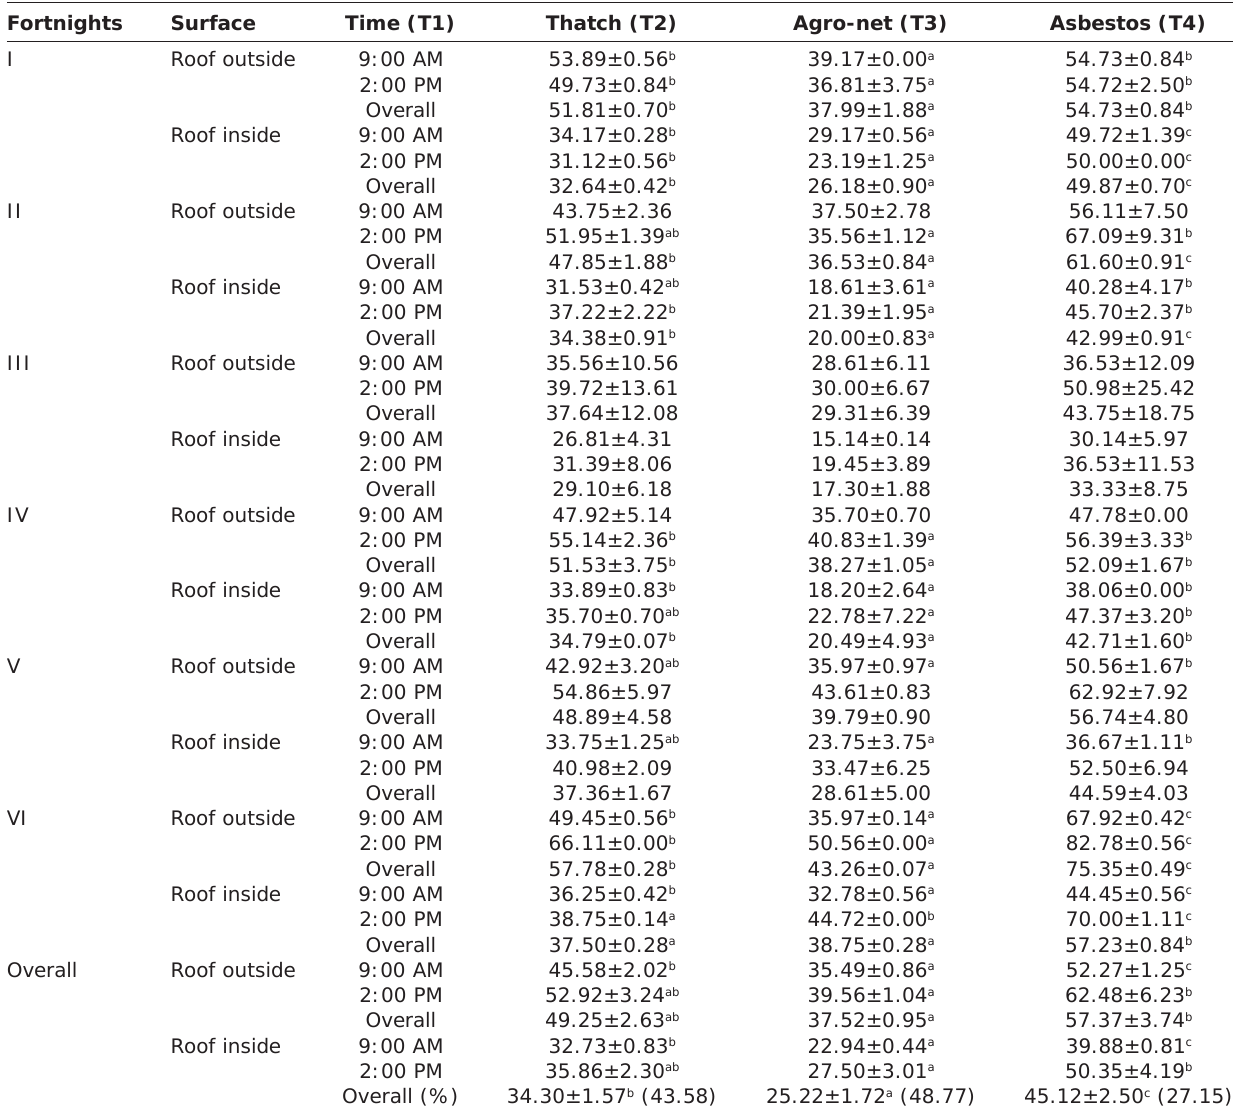
Table-1: Mean±SEM of ST (°C) of different shade material*. Fortnights